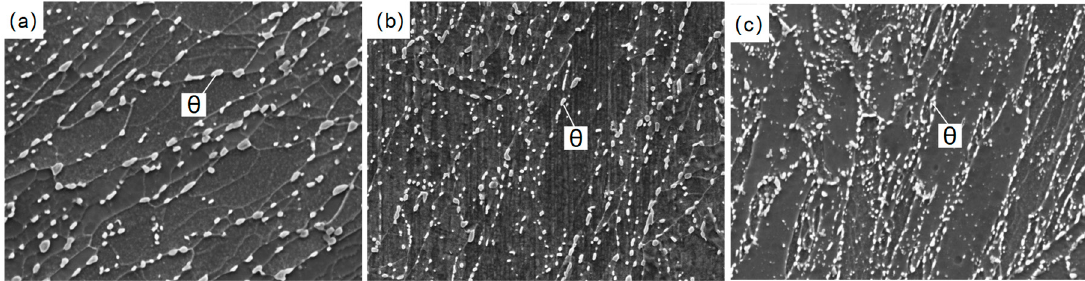
Figure 4. SEM images of the samples heated to 978 K just before reversion at the heating rate of ( a ) 0.1 K/s, ( b ) 1 K/s, and ( c ) 20 K/s.